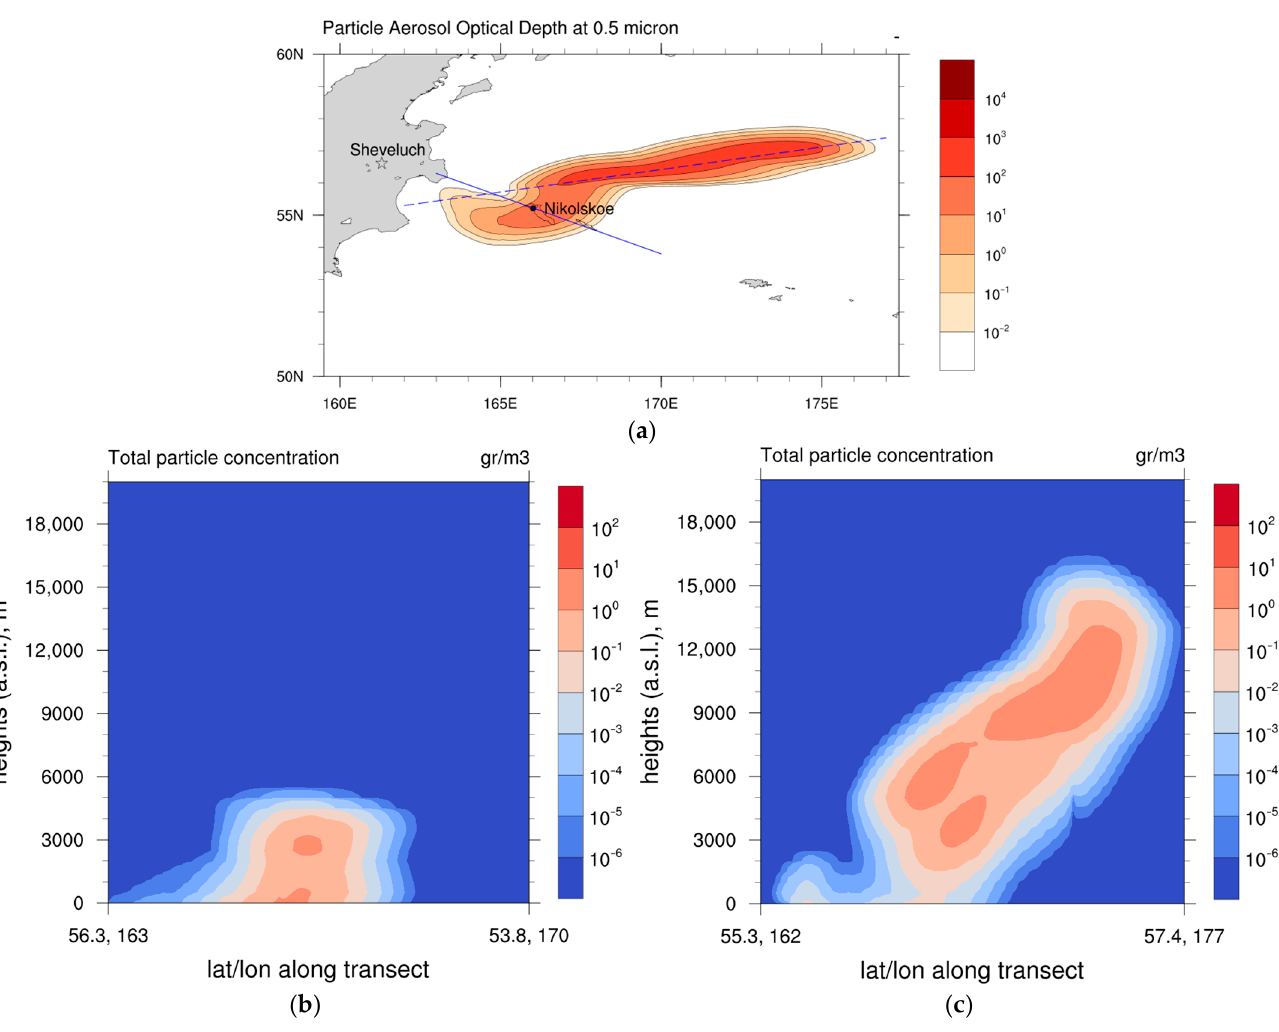
Figure 8. The visualization of the modeling results for the Sheveluch eruptive cloud as of 21:37 UTC, 11 November 1964: ( a ) The optical density of the aerosol; ( b ) Ash concentration: cross-section along the solid line in ( a ); ( c ) Ash concentration: cross-section along the dashed line in ( a ).